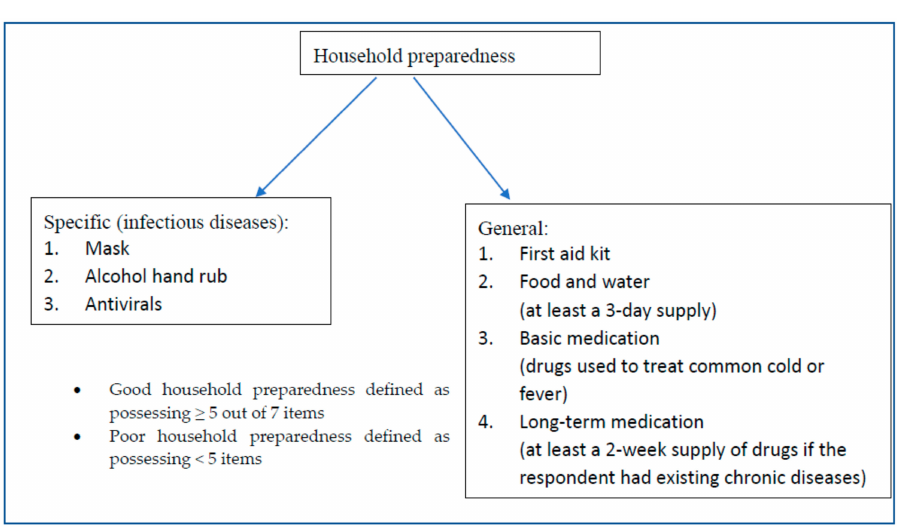
Figure 2. Definition of household preparedness levels and